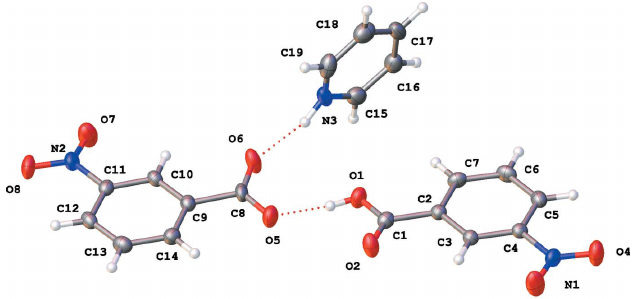
Figure 1 The asymmetric unit of the structure with 50% probability ellipsoids and hydrogen bonds indicated by red dotted lines.